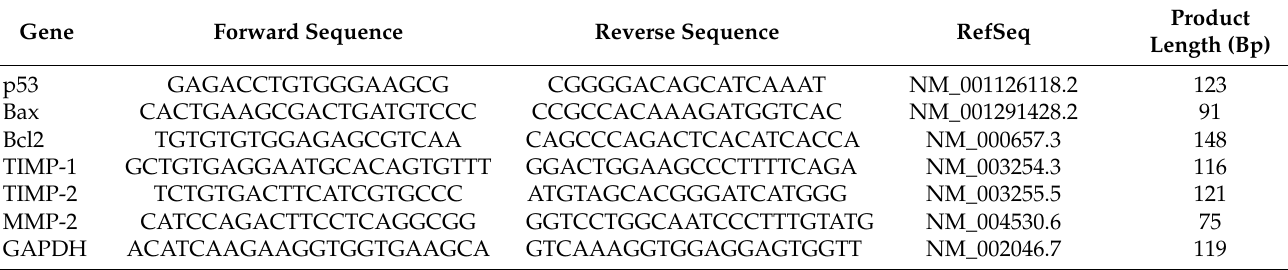
Table 1. qPCR primers used in this